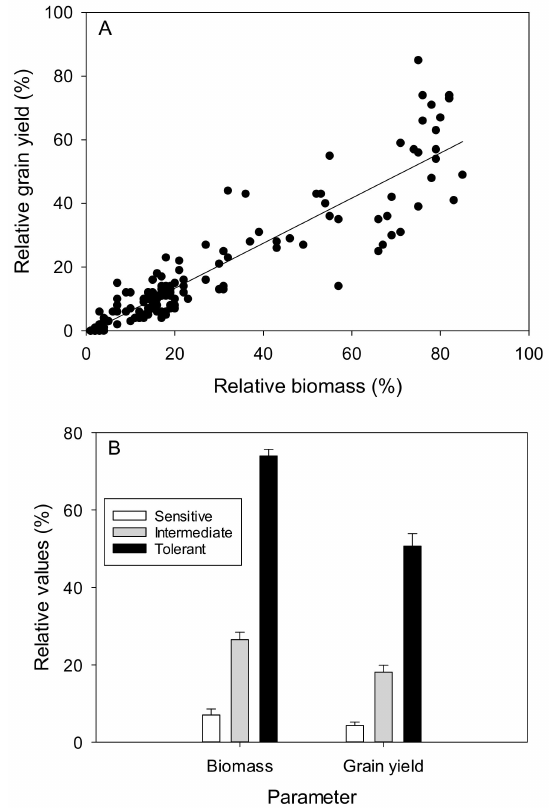
Figure 5. Relative biomass and relative grain yield are highly correlated and the classification of accessions into groups with the preliminary screen of Al 3 + -tolerant, -intermediate, and -sensitive is consistent with final biomass and grain yield. Biomass and grain yield of accessions grown on the un-limed plot are expressed as a percent of the limed plot using the procedure described in the legend of Figure 4. ( A ) Relationship between relative biomass and relative grain yield for all accessions grown in the field ( r 2 = 0.84). ( B ) Relative biomass and relative grain yield of all accessions allocated to the three classes were combined with error bars denoting the standard error and a one-way ANOVA of the data showed significant di ff erences between all groups for each of biomass and grain yield (ANOVA on ranks p < 0.001 between classes; n = 47 for Sensitive, n = 83 for Intermediate, and n = 20 for Tolerant